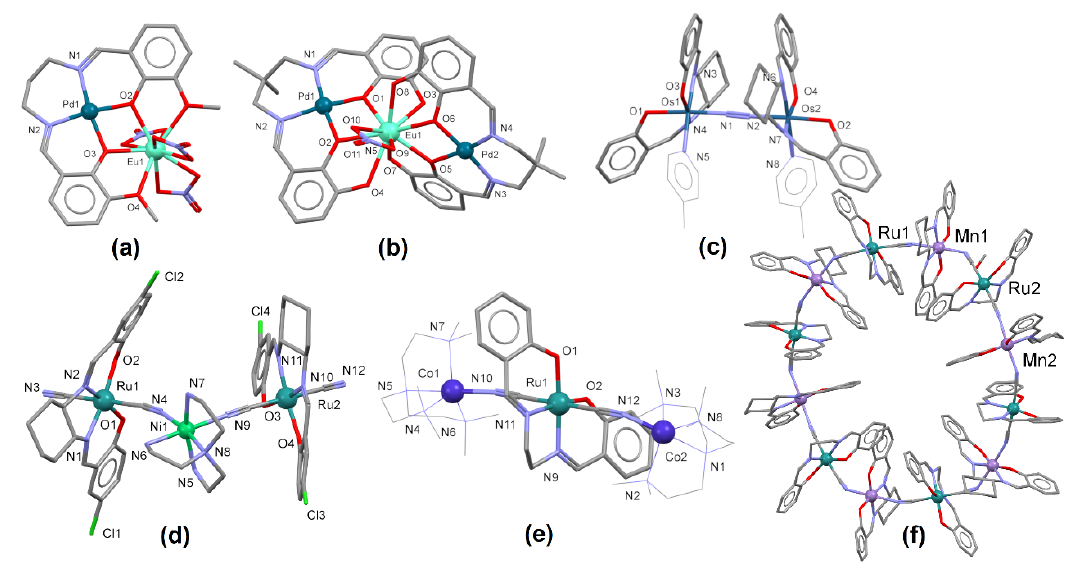
Figure 10. ( a ) Heterobinuclear Pd-Eu complex with bi-compartmental N 2 O 2 -O 2 O ’ 2 Schiff base ligand [157] (CSD Refcode DEMPUJ); ( b ) heterotrinuclear Pd-Eu-Pd coordination compound with propeller like arrangement of two Schiff base ligands [44] (CSD Refcode DIPDAK); ( c ) diosmium μ -dinitrogen complex [158] (CSD Refcode MAHDAC); ( d ) heterobimetallic trinuclear cyano-bridged complex of bis( μ -cyanido)-dicyanido-bis(2,2 ’ -[( R , R )-cyclohexane-1,2-diylbis(azanylylidenemethylylidene)]bis(4-chlorophenolato))-(tris(2-aminoethyl)amine)-nickel(II)-bi-ruthenium(III) [159] (CSD Refcode KILRIJ); ( e ) trinuclear Co-Ru-Co cyanido-bridged complex [160] (CSD Refcode BODHEJ); ( f ) dodecanuclear macrocyclic cyanido-bridged 3d-4d heterobimetallic complex [161] (CSD Refcode VIVCOV). Solvent molecules and hydrogen atoms were omitted for clarity.